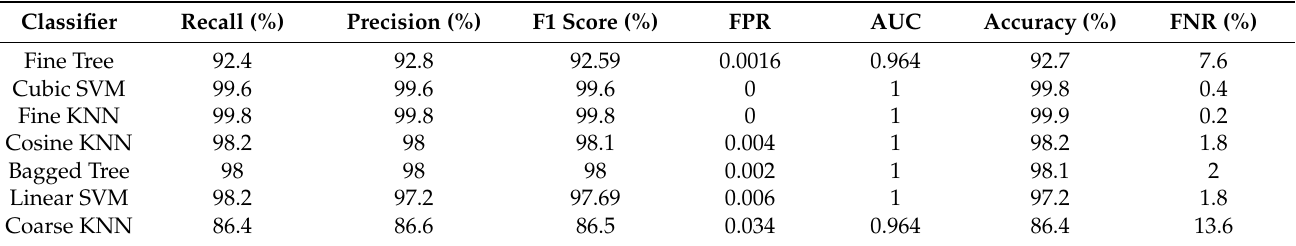
Table 4. Classification results using Alexnet model